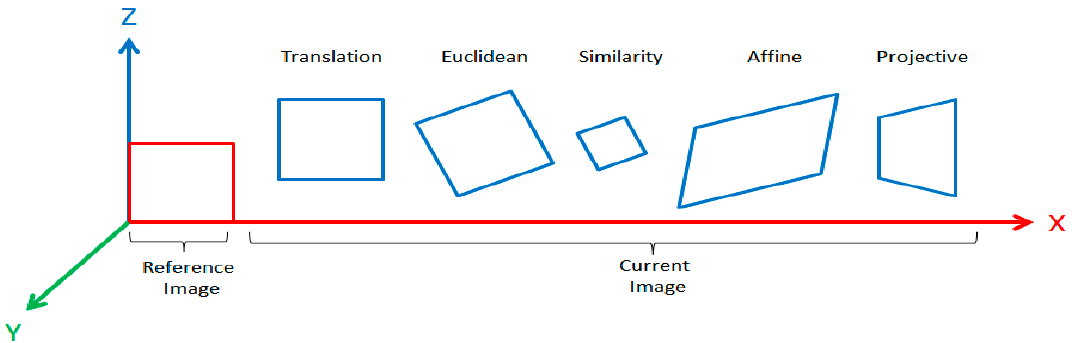
Figure 8. Two-dimensional (2D) geometric image transformations (adapted from Szeliski [1]).